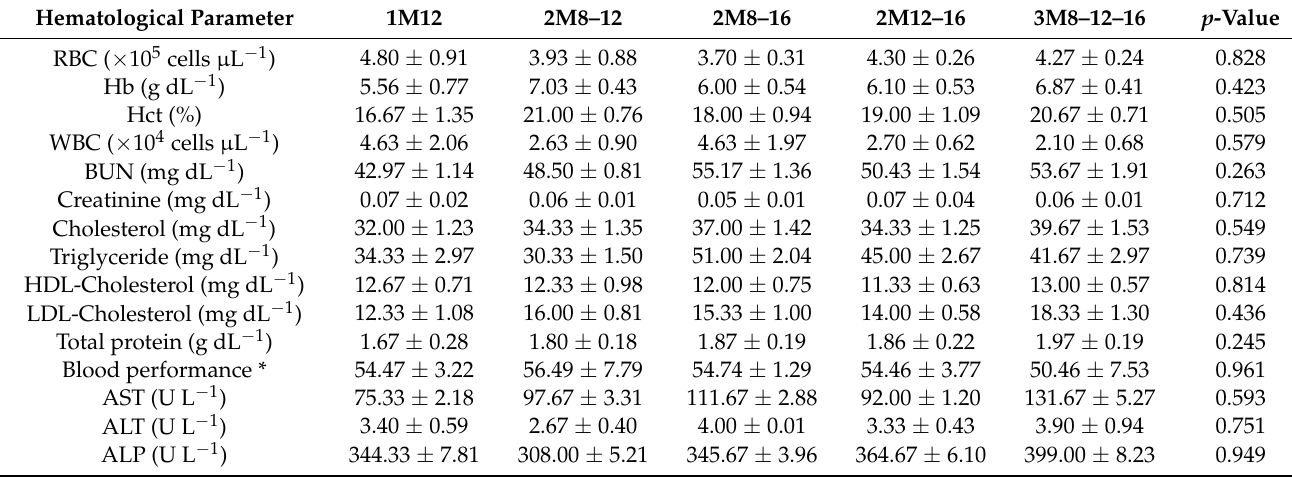
Table 5. Hematological parameters of hawksbill sea turtle subjected to feeding at various frequencies. The sampling was done at the end of the 8-week